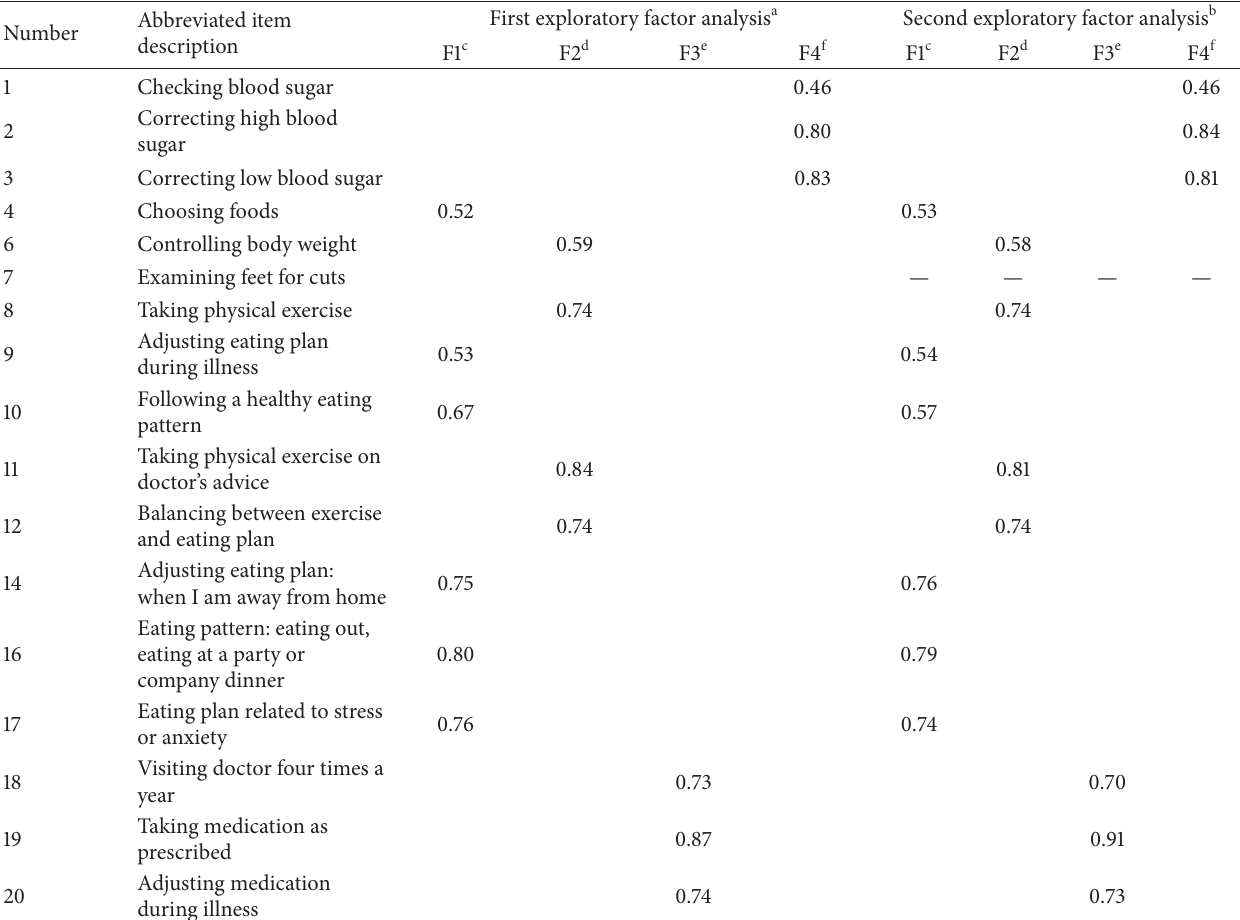
Table 2: Exploratory factor analyses.